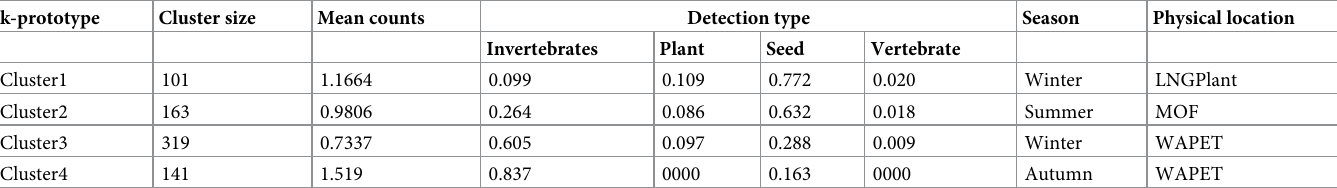
Table 9. Clustering using both numeric and categorical variables for detection data from Barrow Island between 2009 and 2015.